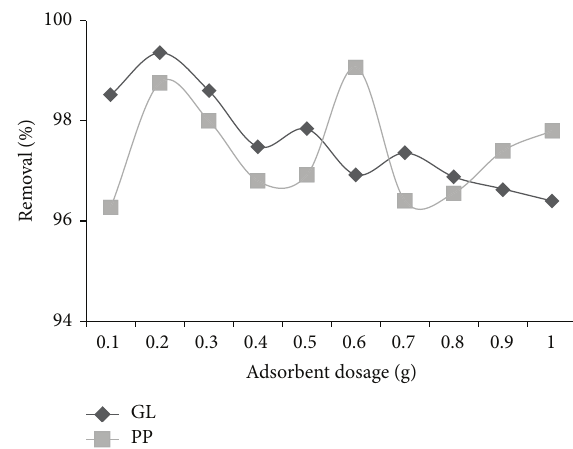
Figure 10: Comparative study of effect of adsorbent dose on percentage removal of